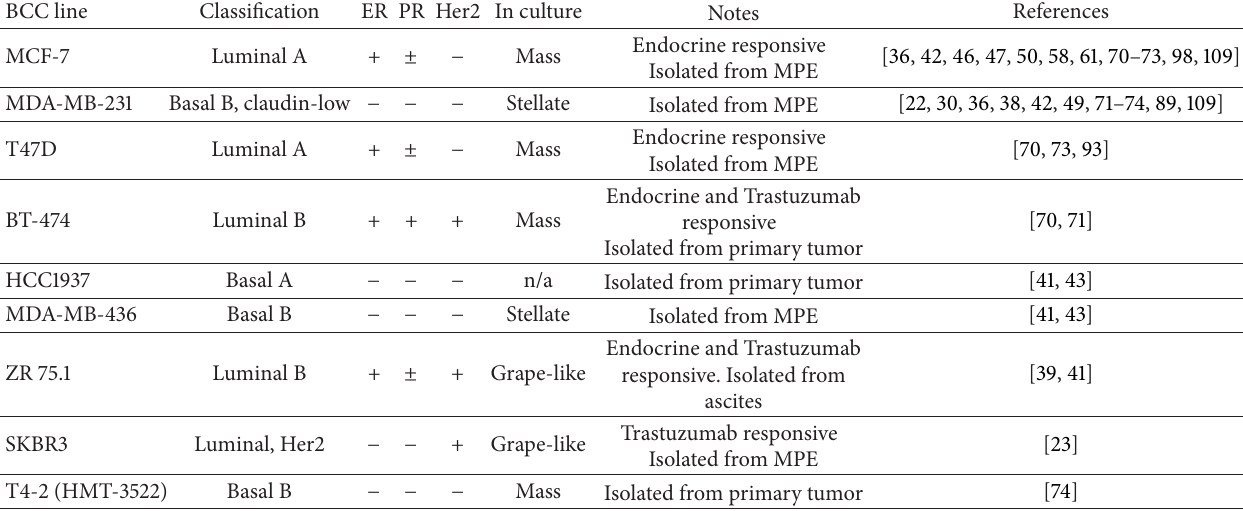
Table 1: Most common human BCC lines used for investigation of ADSC/breast cancer interaction [68, 69,